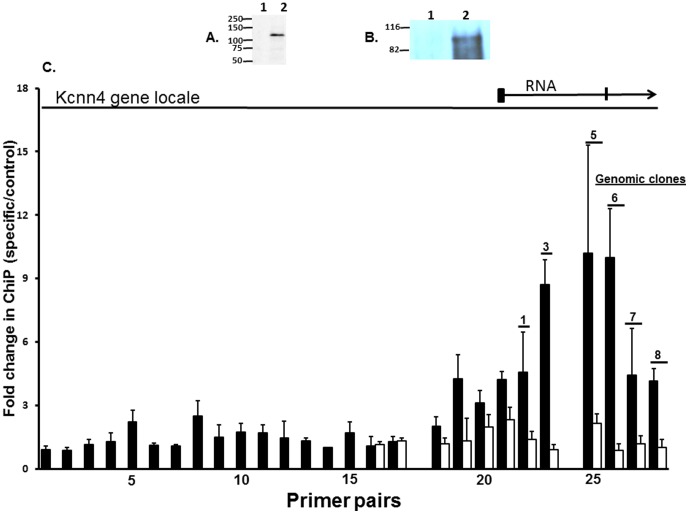
Characterization of anti-mineralocorticoid receptor antibody (SC-11412) and its use in chromatin immunoprecipitation (ChIP) assay.[A] Characterization of SC-11412 antibody: The CHOK1 cells were transfected with vector (lane-1) or the vector containing a mineralocorticoid receptor (MR) (lane-2), labeled with 35S-methionine, immunoprecipitated with SC-11412 antibody to MR, resolved on SDS-PAGE, and the gel used to expose X-ray film. [B] Immunoprecipitation of MR-like proteins from rat colonic epithelial cells: Protein extracts of the colonic epithelial cells from an aldosterone rat was immunoprecipitated with the control (lane-1) or the SC-11412 (lane-2) antibody. The immnoprecipitated proteins were resolved on SDS-PAGE and transferred to the nitrocellulose membrane and probed with the SC-11412 antibody. [C] ChIP assay of MR: Numbers on the X-axis represent primer pairs directed to 1 kb blocks starting at approximately 20 kb upstream (number-1) of the Kcnn4 presumed transcript start site (TSS) and extending to 10 kb downstream (number-29) of the presumed TSS (located in block 21). The Y-axis represents fold enrichment in the RT-PCR comparing the specific to the control antibody. Data presented represents mean ± SE of 4 independent experiments using distal colon epithelial cells from aldosterone (closed bars) and normal rats (open bars). The RNA transcript is indicated by an arrow. The presumed promoter region is immediately to the left of the arrow. Exons 1 and 2 are indicated by blocks. Genomic regions cloned in pGL4.23 are indicated by bars and are numbered.